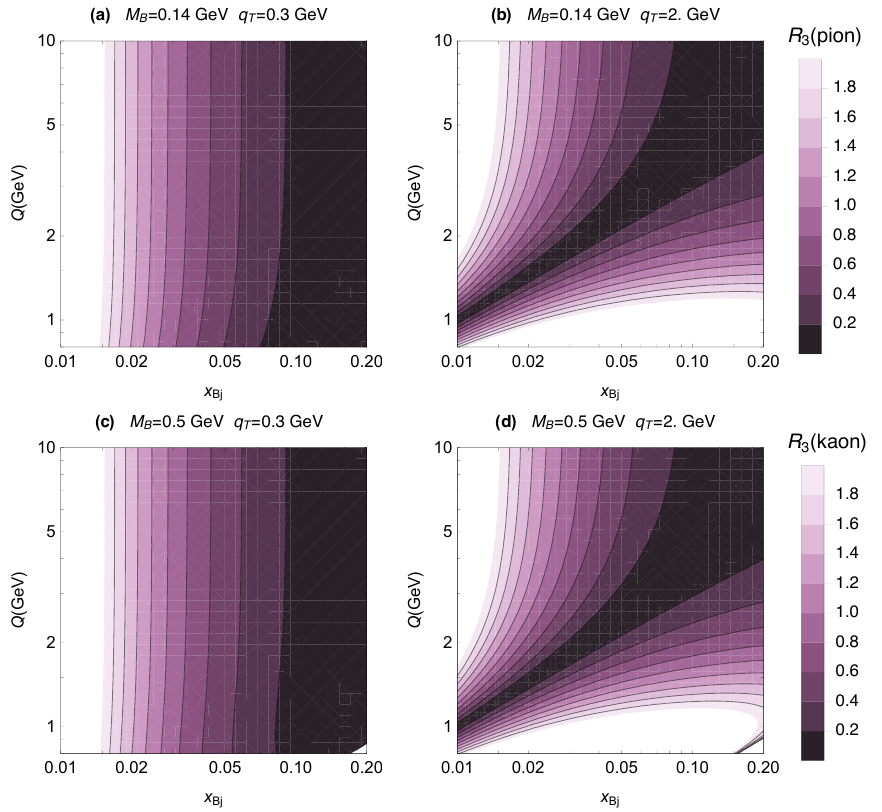
Figure 12 . Spectator virtuality ratio, R 3 , from eq. (4.18) for (cid:12)xed z h = 0 : 25, (cid:16) = 0 : 3 and (cid:24) = 0 : 2. Top panels show the ratio for M B = m (cid:25) at (a) small transverse momentum ( q T = 0 : 3 GeV) and (b) q T = 2 : 0 GeV. Similar cases for M B = m K are shown in the bottom panels, (c) and (d). Note that both x Bj and Q axes are shown in logarithmic